Question: What kind of plot is shown here?
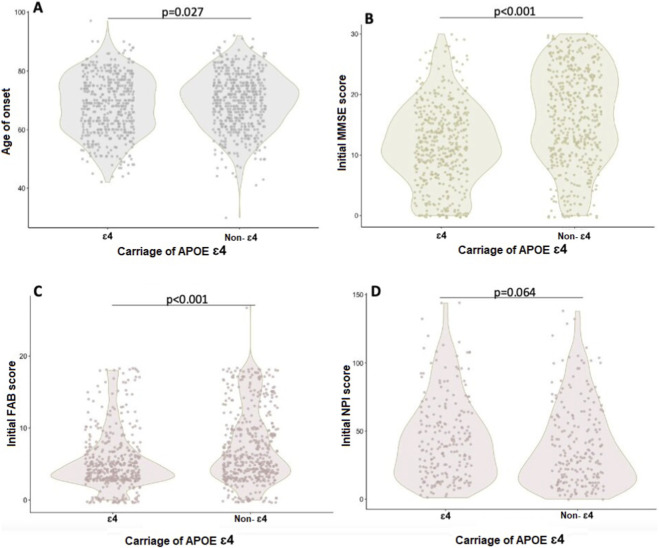
Answer: box